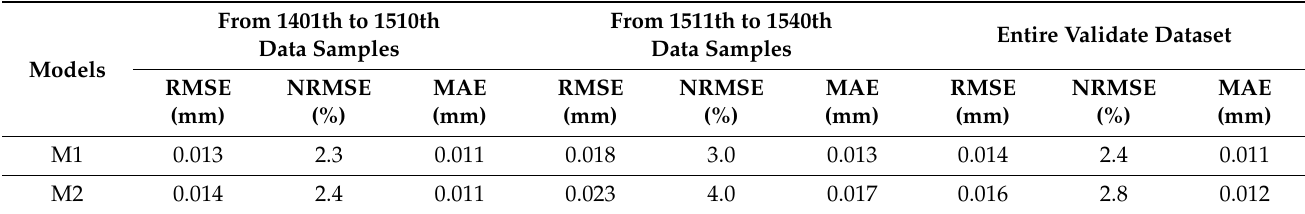
Table 5. Estimation errors of the FDE horizontal vibration in validation dataset.